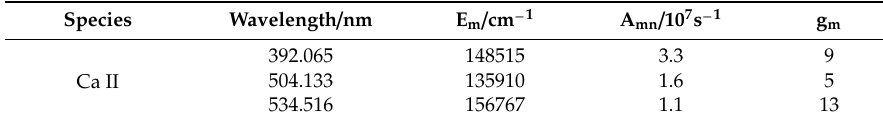
Table 3. Parameters of calcium atomic emission line.